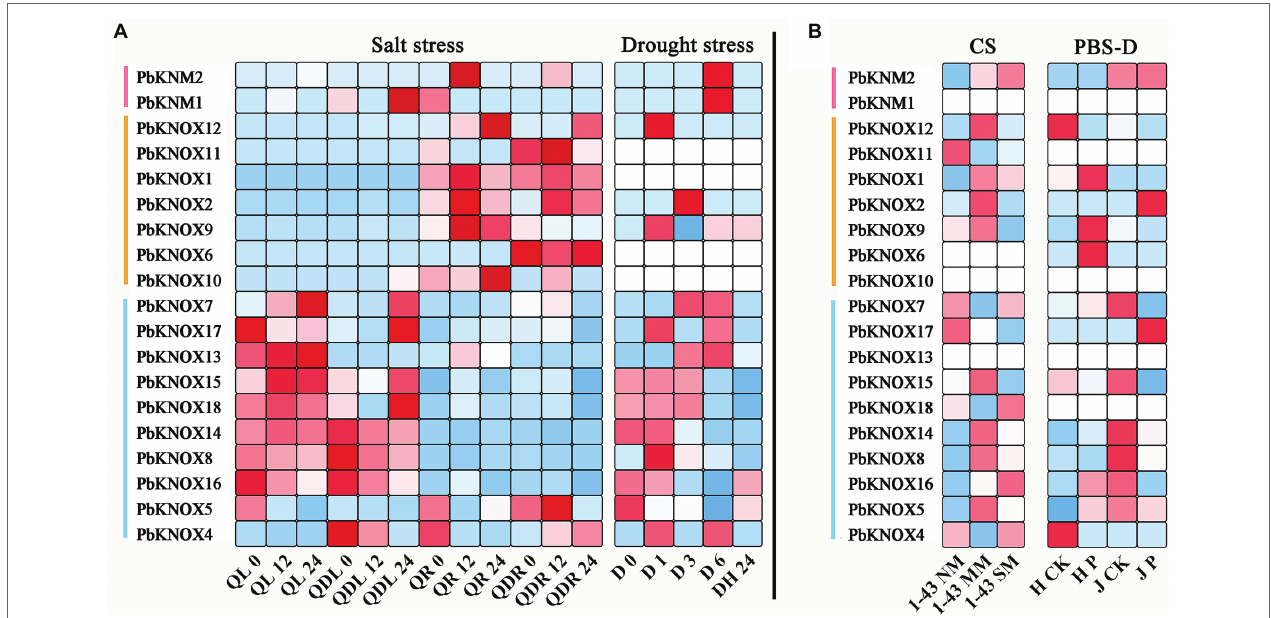
FIGURE 5 | Expression profiles of PbKNOX genes under abiotic and biotic stress. (A) Abiotic stress included salt and drought stress. (B) Biotic stress included cork spot and pear black spot disease. CS, cork spot; MM, moderate disease mesocarp; NM, normal mesocarp; PBS-D, pear black spot disease; QL, “Qaup-1”